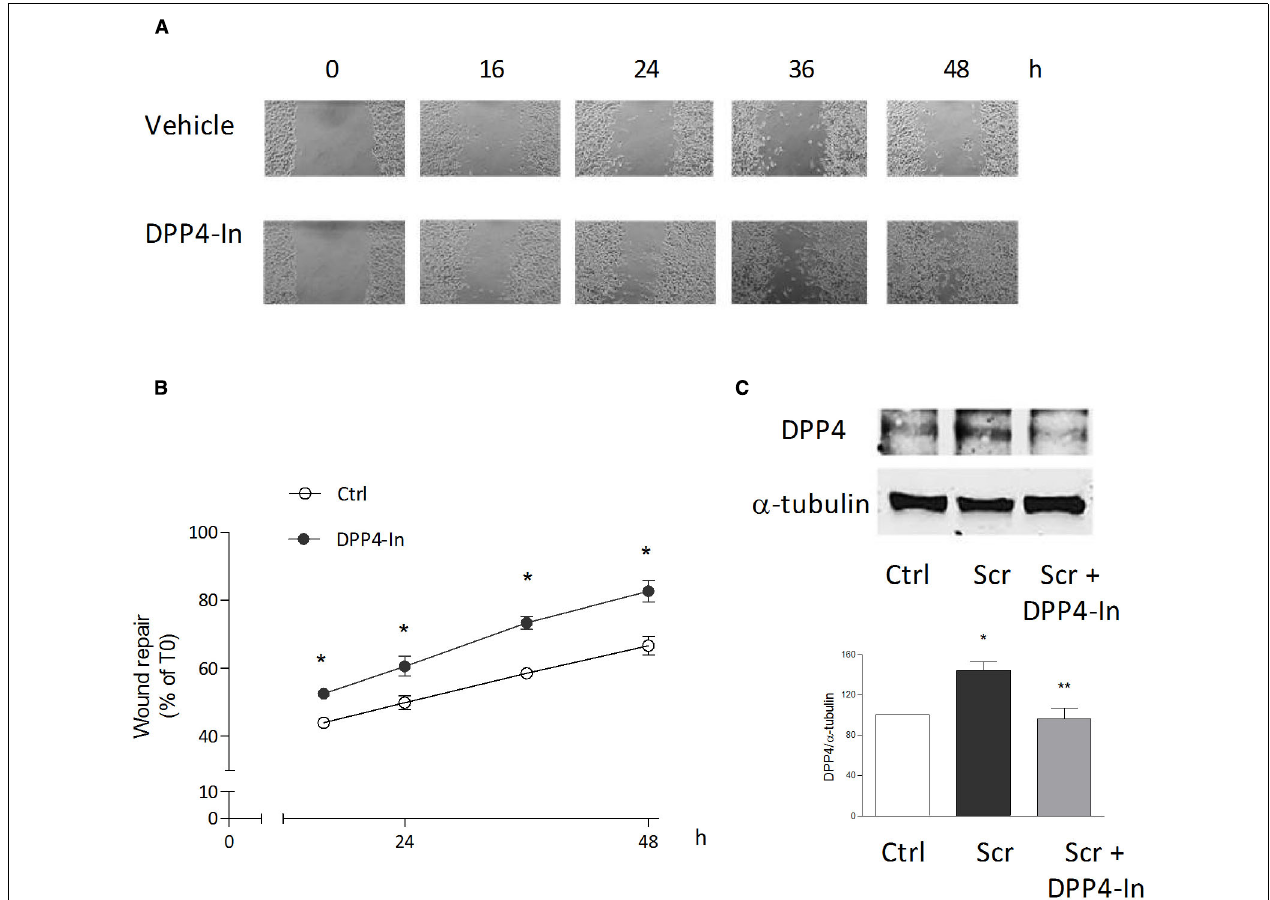
FIGURE 2 | Inhibition of DPP4 increases wound closure in a monolayer of NTCC 2544 keratinocytes. Treatment with DPP4-In (10 m M) increases the ability of keratinocytes to migrate into the empty area and to repair the wound at all time points examined (A,B) . Representative images of the wound repair over time are reported in (A) . This effect is accompanied by reduction of the expression